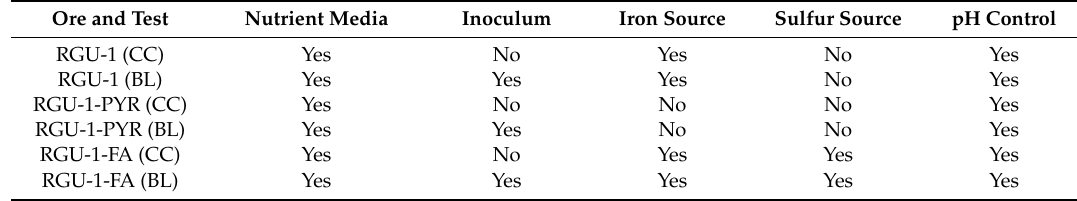
Table 2. Summary of bioleaching (BL) and chemical control (CC) experiments.